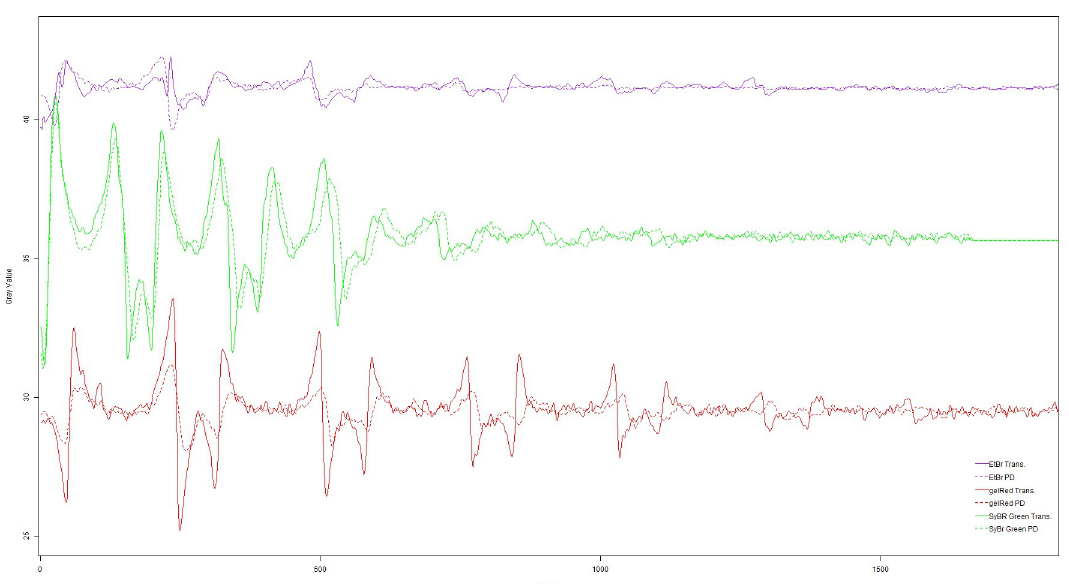
Fig 7. Gel images analysis. Analysis of intensity quantification (by pixel density) of the agaroses gel images obtained with a conventional transilluminator (full lines—T) and our proposed system (dashed lines—PD), with the three used dyes: Ethidium bromide (purple lines); GelRed (red lines); SYBR green (green